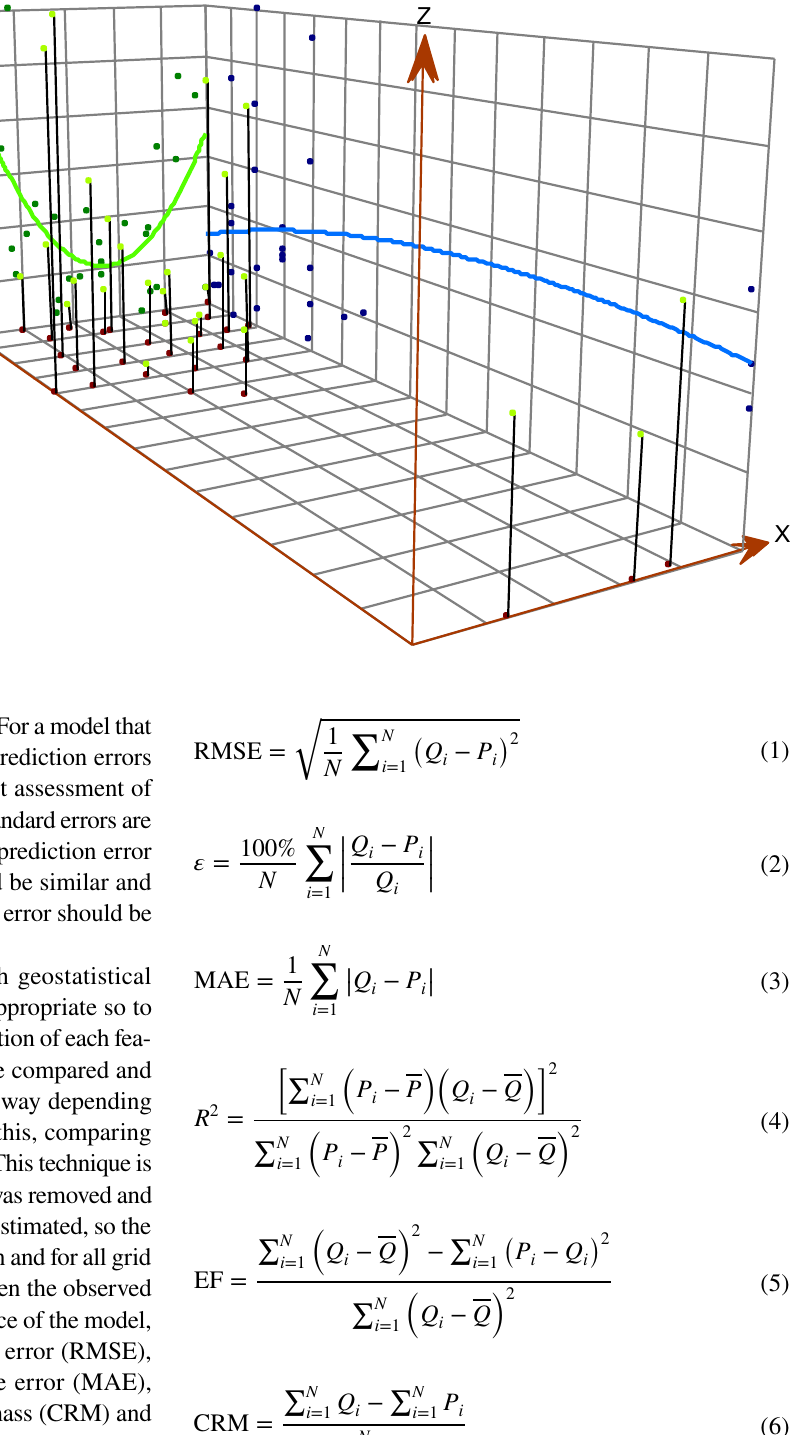
Fig. 4 Trend in X and Y axes direction